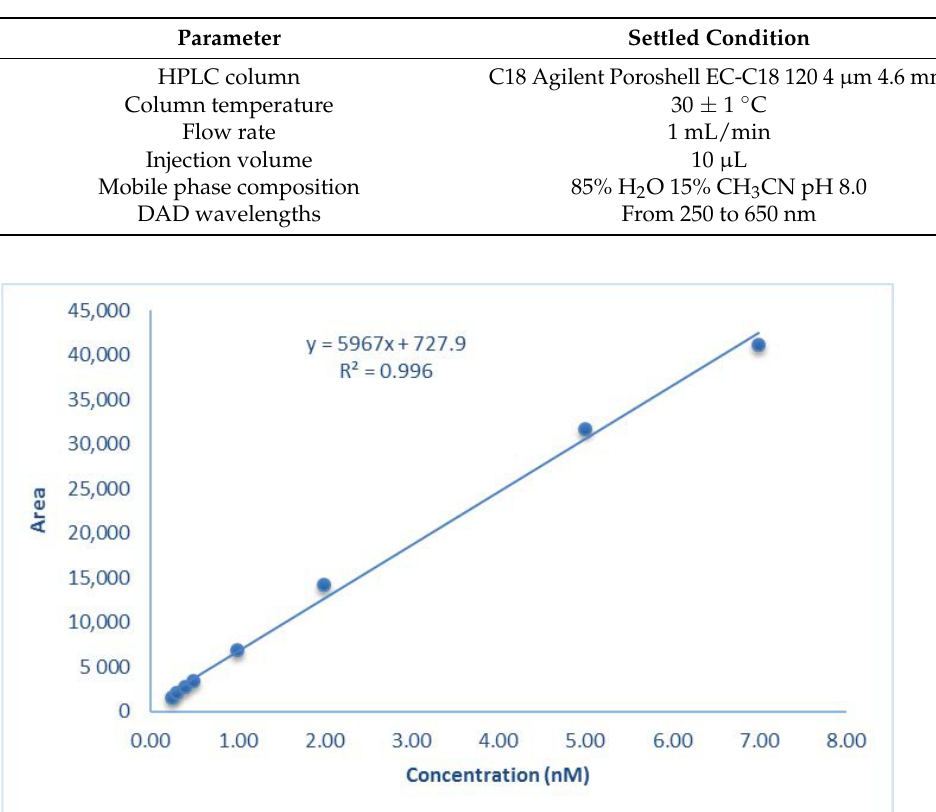
Table 2. HPLC-DAD settled conditions.